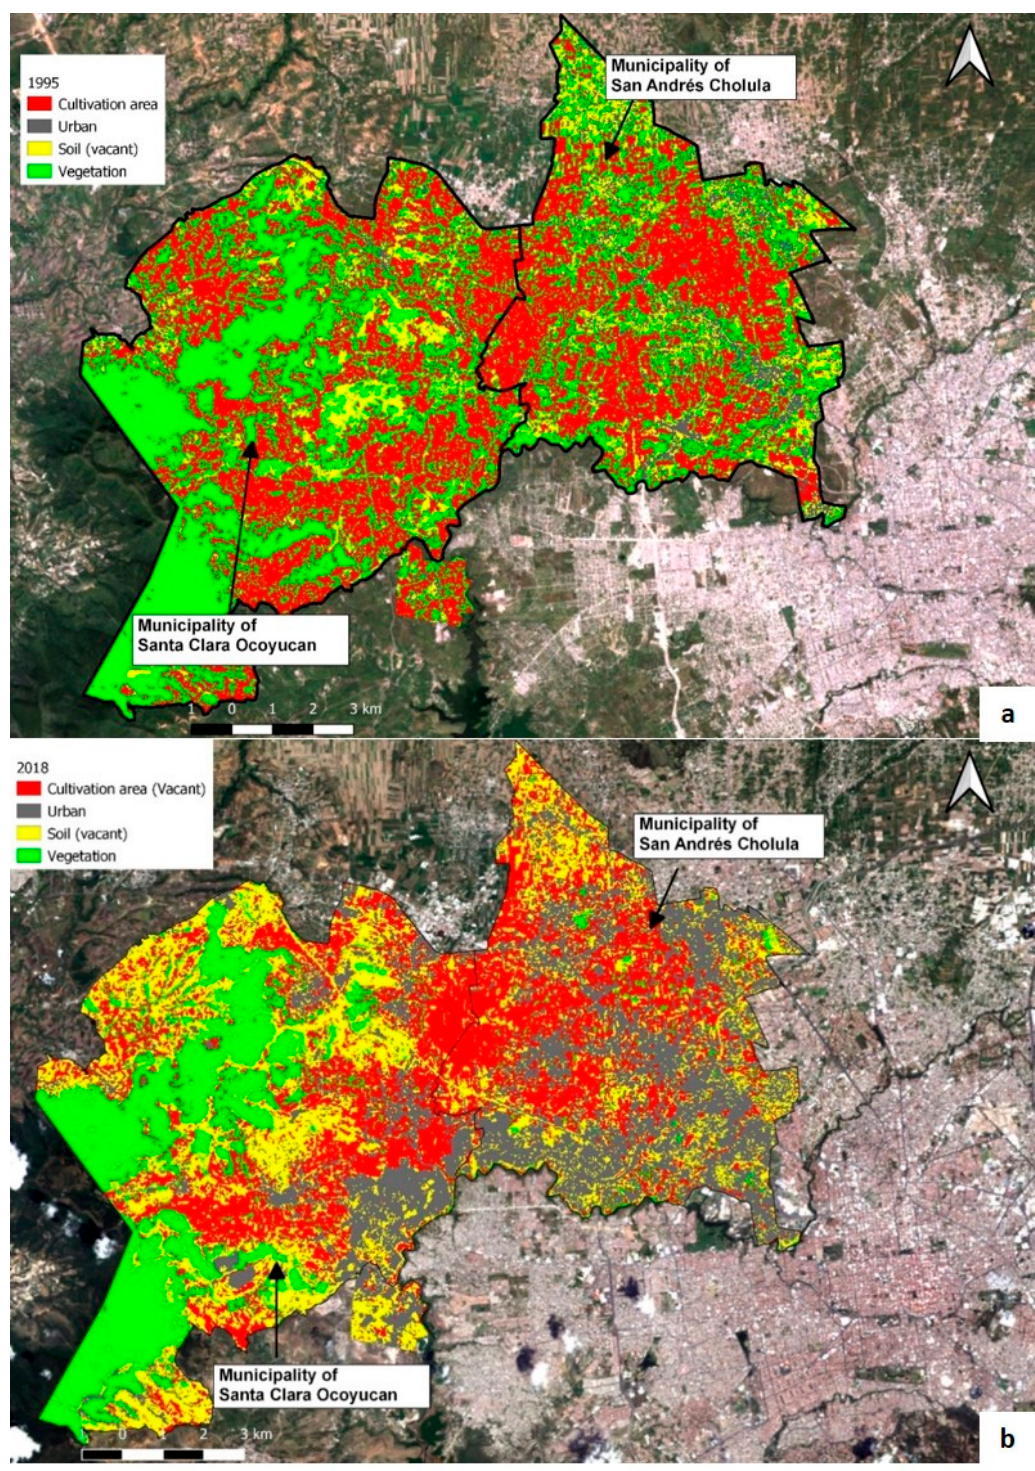
Figure 3. Land use classification data in ( a ) 1995 and ( b ) 2018.